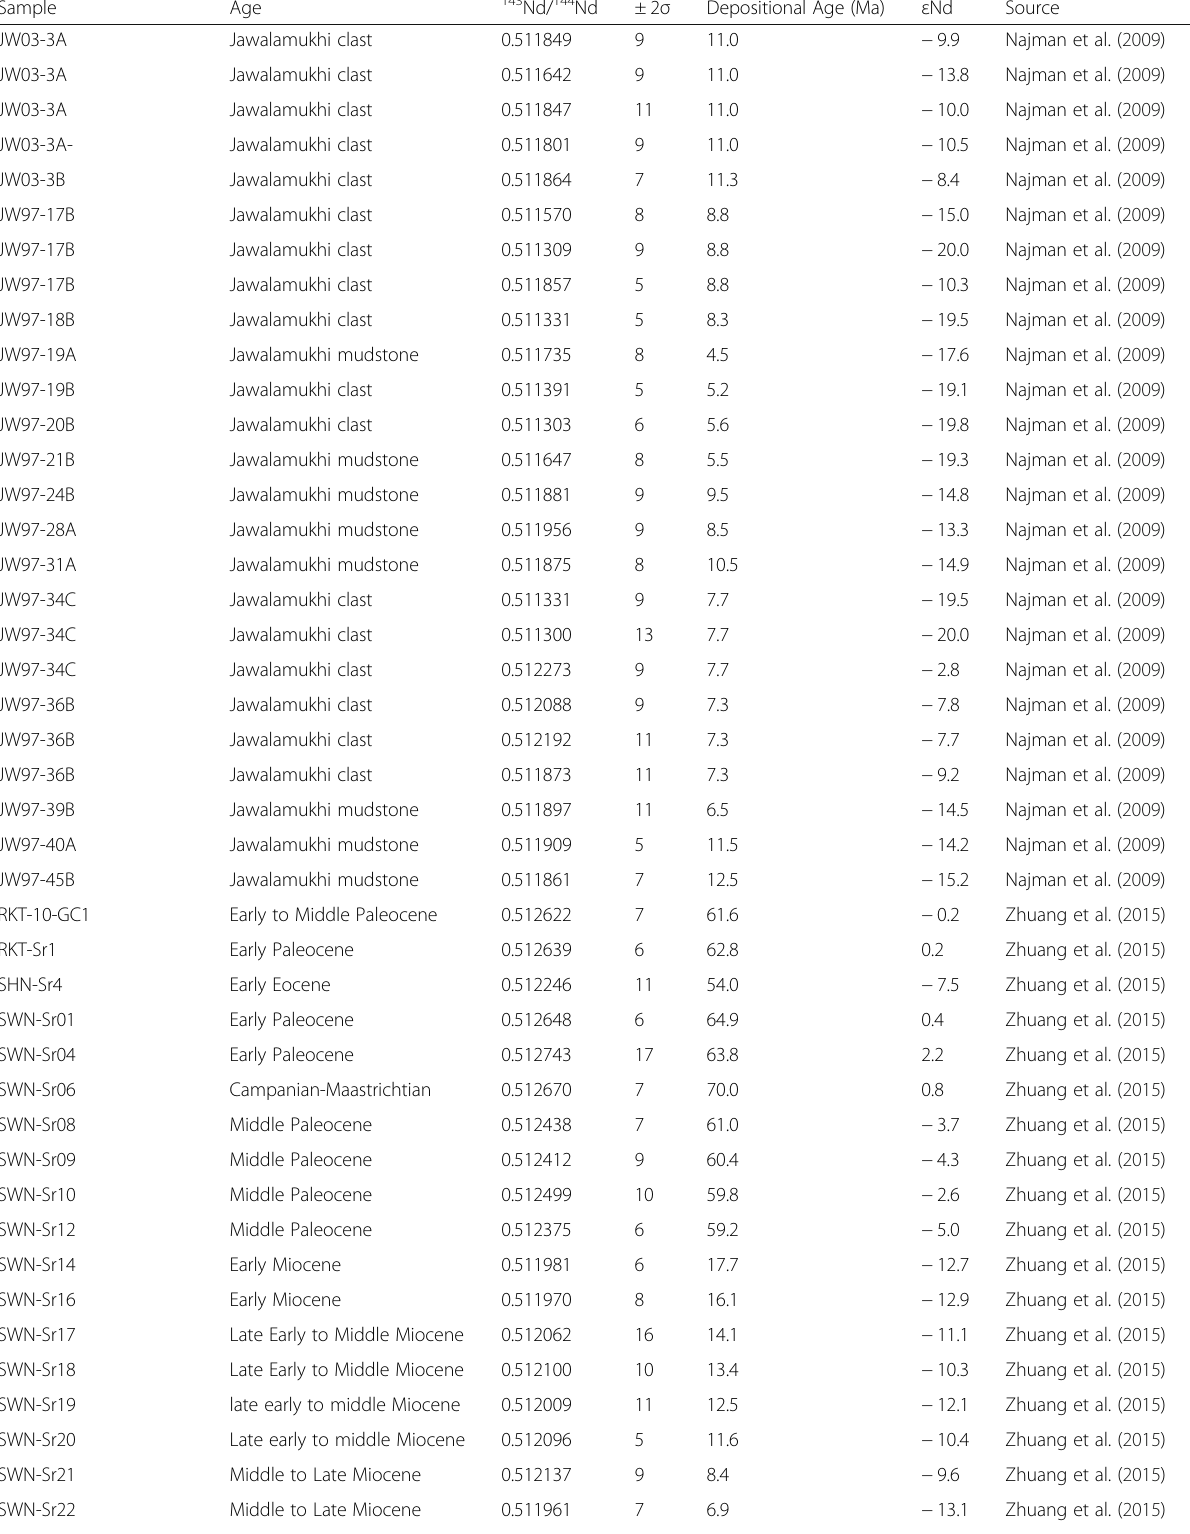
Table 1 Synthesis of published Nd isotope data used in this study, together with a reference to the original sources from which they were derived